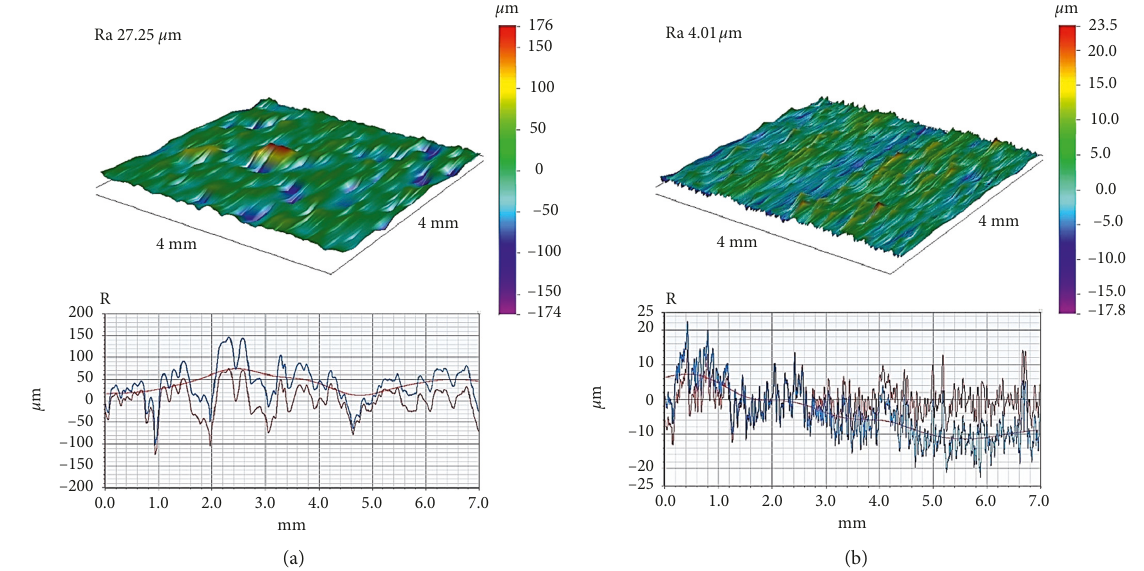
Figure 7: Surface roughness of the down face of overhang structures: (a) manual and (b) wire EDM support-removal.